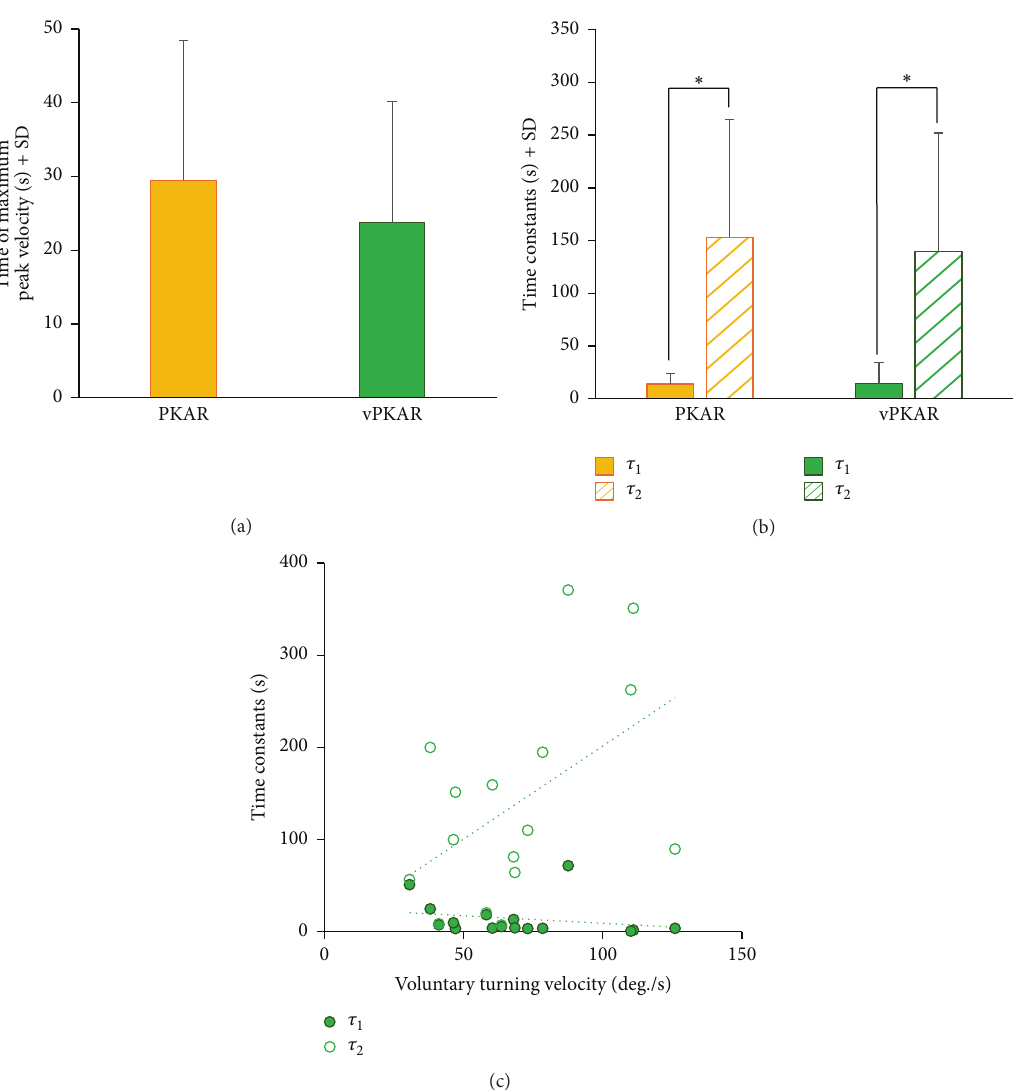
Figure 2: Peak velocity and time course of the posteffects. (a) Time at which rotation velocity peaked during PKAR (yellow bar) and during the posteffect of voluntary turning (vPKAR, green bar). (b) Time constants of the exponential fit to the time course of the two posteffects. 𝜏 𝜏 1 was the time constant of the initial rise and 2 was the time constant of the decay in angular velocity over time. (c) For each subject, the time constants ( 𝜏 1 green filled symbols, 𝜏 2 open symbols) of vPKAR are plotted against the rotation velocity of voluntary turning. ∗ indicates significant difference ( 𝑝 < 0.05 ) between mean time constants